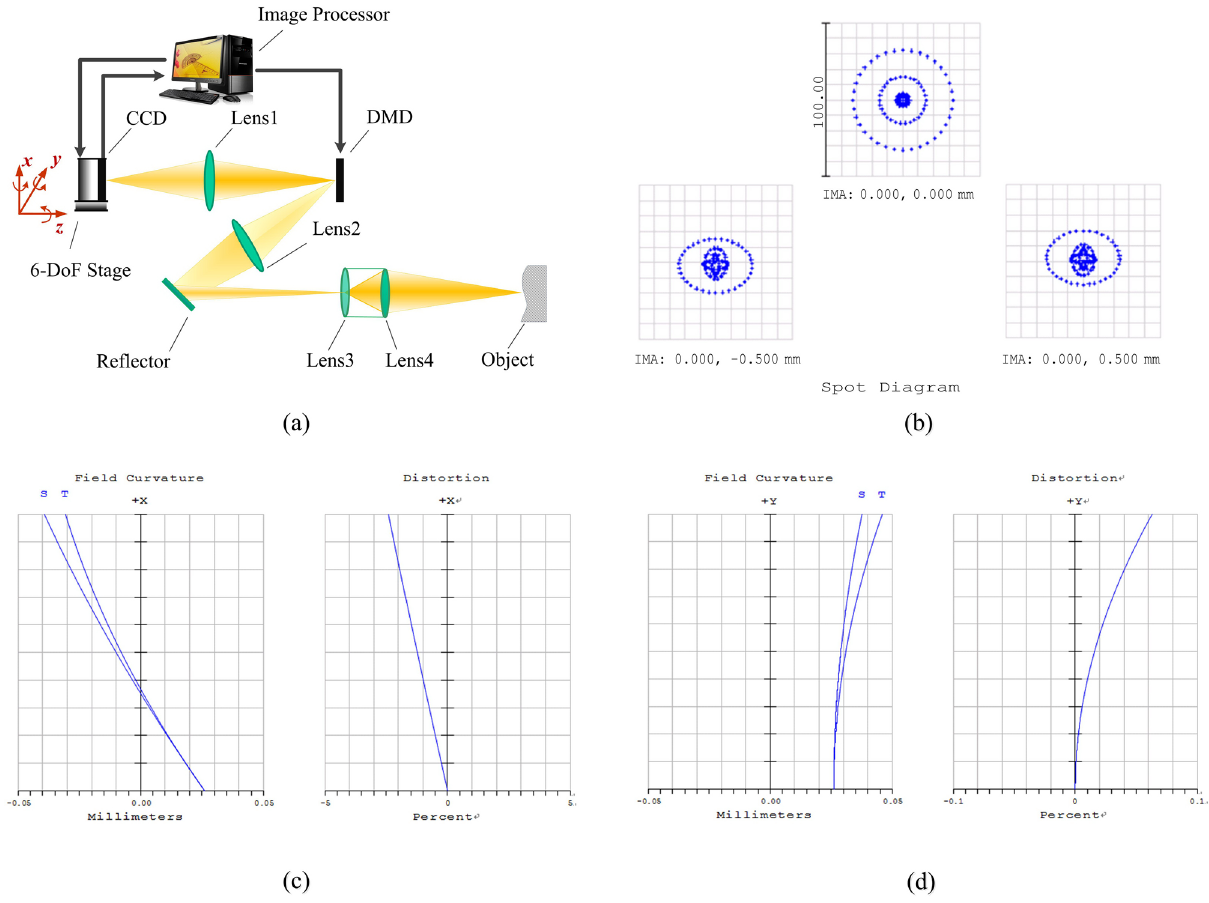
Figure 1. DMD imaging system. ( a ) The architecture of DMD camera. ( b ) The spot diagram of DMD camera system. ( c ) The distortions on x-axis. (d) The distortions on